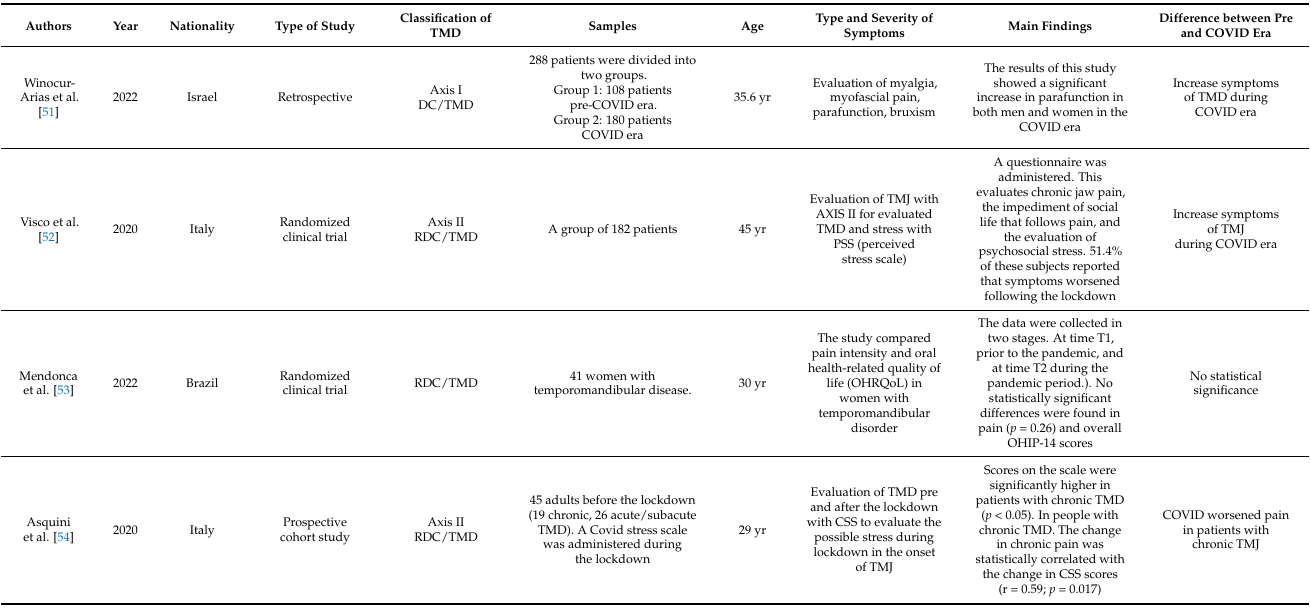
Table 2. Summary of the analyzed